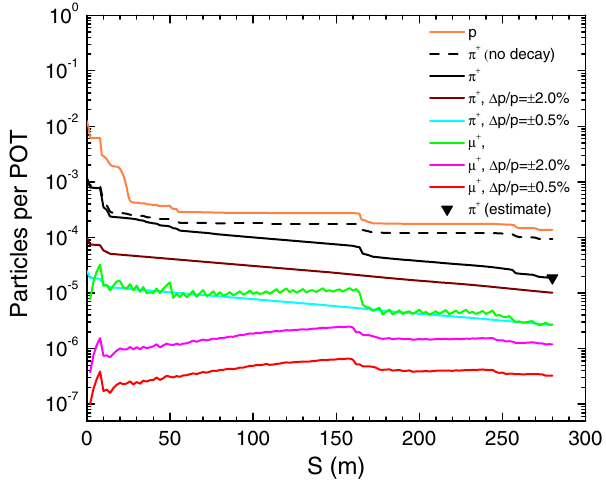
FIG. 5. The simulated performance along the M2- and M3-line, where the evolution of secondary particles is shown as a function of distance along the channel for different momentum accep- tances. The dashed line shows the performance of pions when decays are not included. The final number of pions is 1 . 87 × 10 − 5 per POT at the end of the channel ( S ¼ 280 m), which is in agreement with our theoretical findings (triangle). One should note that S ¼ 0 is the same point as in Fig. 2(b).